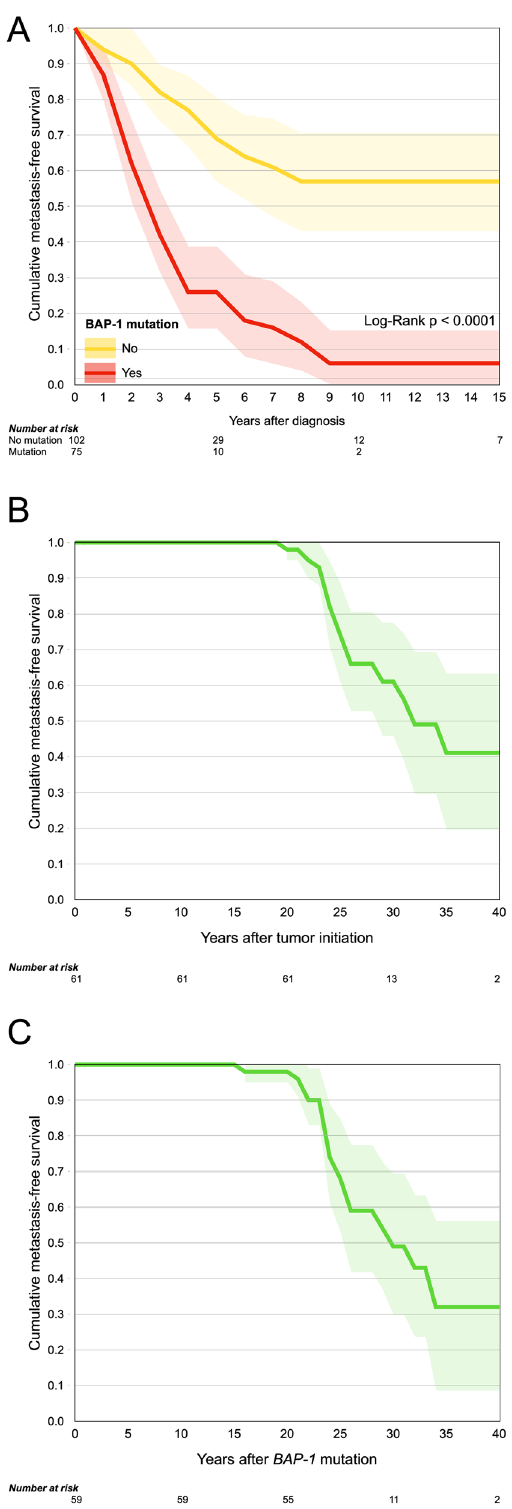
Figure 2. Cumulative metastasis-free survival proportions. ( A ) Survival after diagnosis for patients with a BAP1 mutation or low immunohistochemical BAP1 expression (red) versus no BAP1 mutation or high immunohistochemical BAP1 expression (yellow, Log-Rank p < 0.0001). ( B ) Survival after tumor initiation, which was estimated to occur 22.3 years before diagnosis (SD 1.4). ( C ) Survival after BAP1 mutation, which was estimated to occur 20.6 years before diagnosis (SD 2.5). Green areas represent 95% confidence